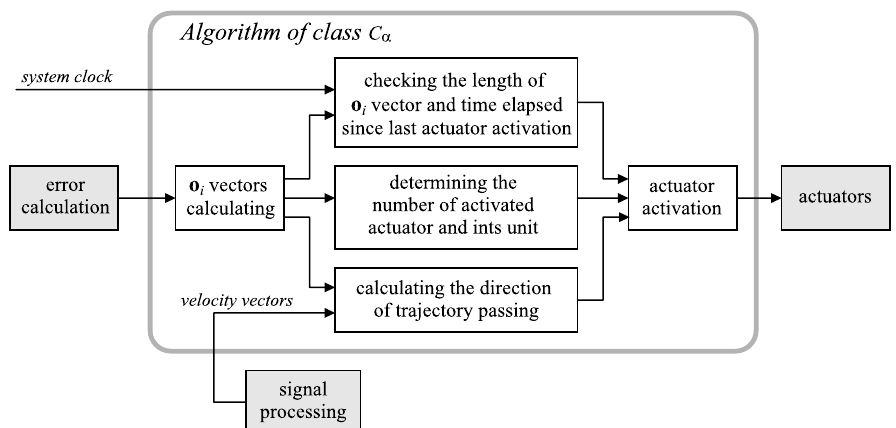
Figure 7. A simplified diagram of the signal flow of the class C α algorithm. The elements of the general system (Figure 2) are depicted in